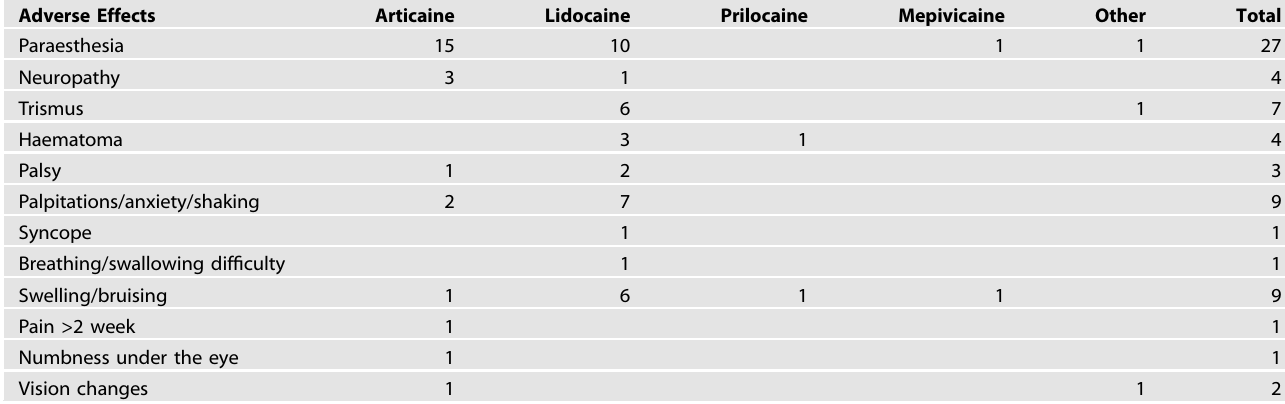
Table 2. Adverse effects by dental anaesthetic type.